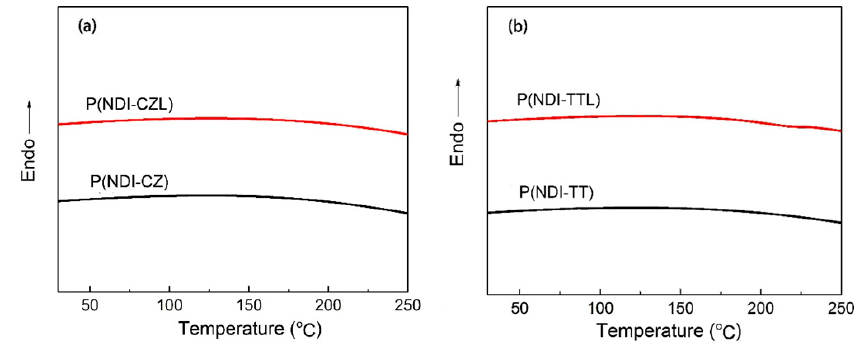
Figure 3. The differential scanning calorimetry (DSC) thermograms of the polymers. ( a ) for P(NDI-CZ), P(NDI-CZL) and ( b ) for P(NDI-TT), P(NDI-TTL).